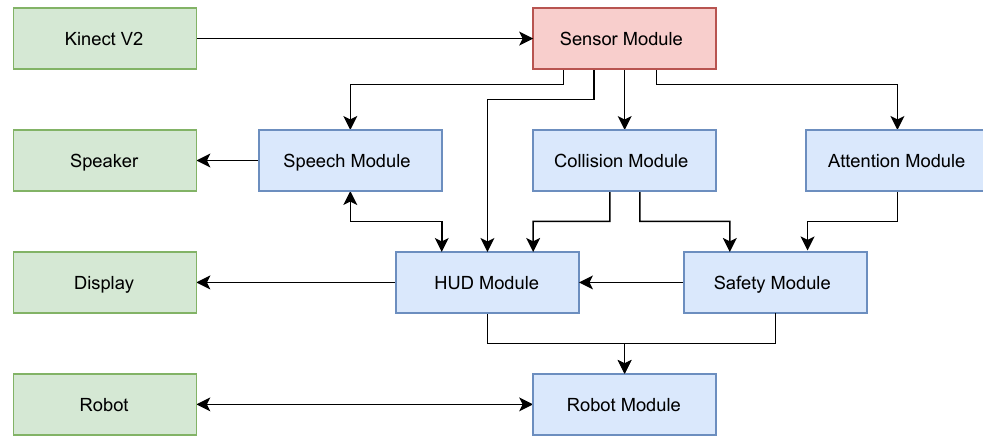
Figure 3. Final schematic representation for the interaction of the components (system